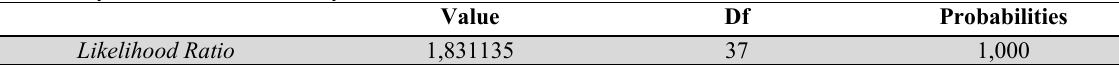
The summary of the heteroscedasticity test